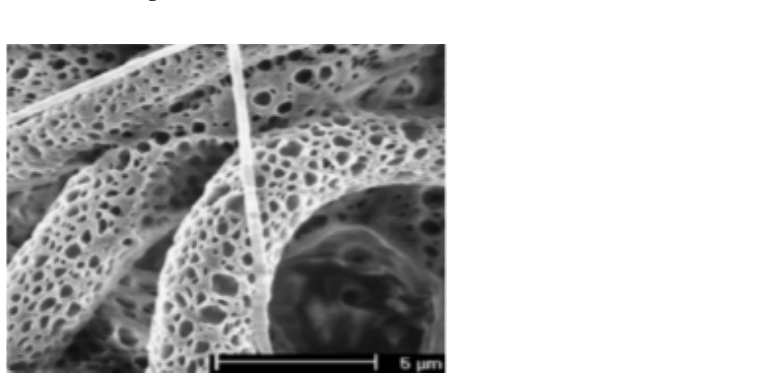
Figure 5. SEM micrograph of a porous electrospun fiber (adapted from [80], published by MDPI,